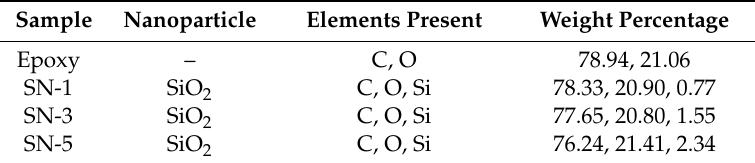
Table 2. Energy-dispersive X-ray spectroscopy (EDX) element detection and weight percentages.